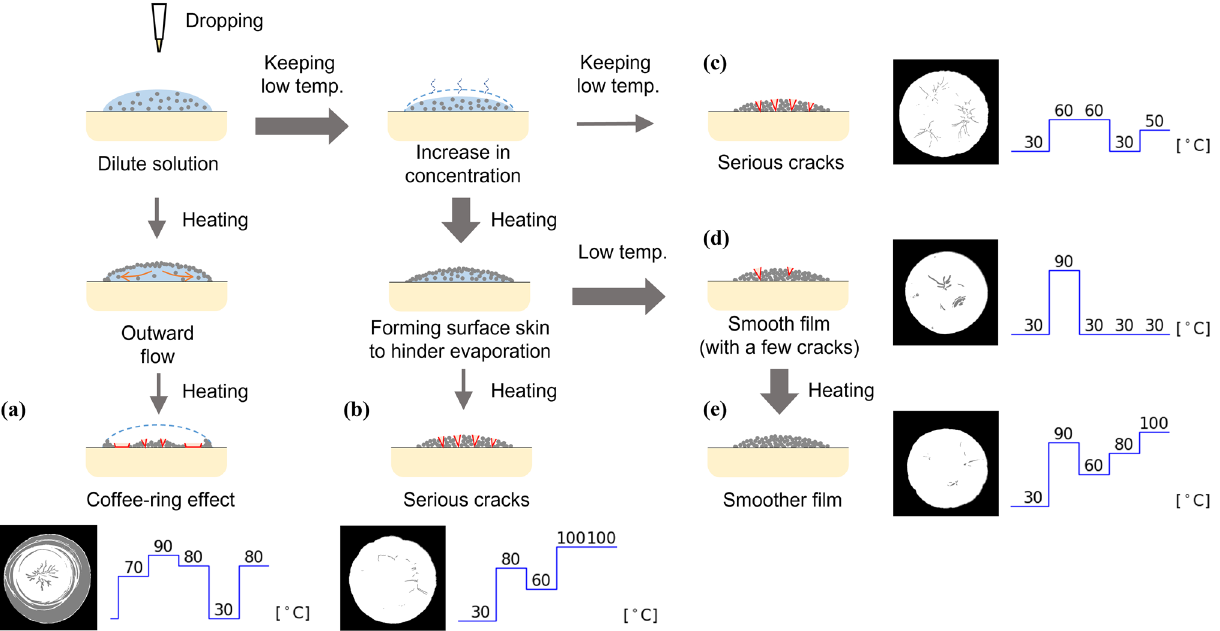
Figure 6. Illustration of the hypothesis of the mechanism of how a low–high–low temperature profile reduces defects during drying. The temperature profile discovered may correspond to a very limited process